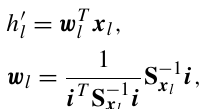
Figure 2. (a) Global (65 ◦ N to 65 ◦ S) mean steric-sea-level height anomaly time series at monthly resolution. Dark blue: dataset gen- erated within SLBC_cci based on Argo data and the CCI SST prod- uct. Light blue: update of the ensemble mean product by Dieng et al. (2017). Changes are expressed with respect to the mean of the reference interval of 2006–2015. (b) Uncertainties assessed for the estimates in (a) . Pink curves (dashed and full lines) show the uncertainty contribution from the SSLHA (steric-sea-level height anomaly) uncertainty and from the global representativity uncer- tainty,